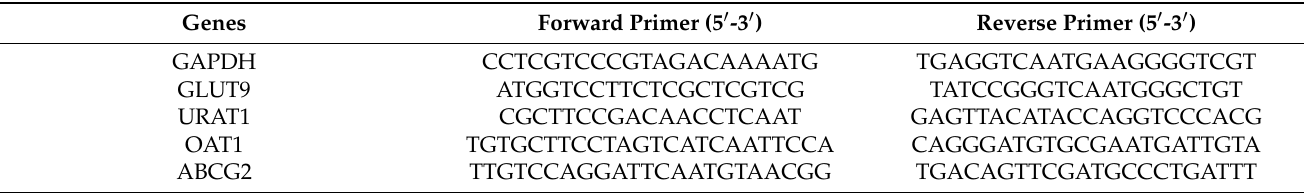
Table 1. Primer sequences of